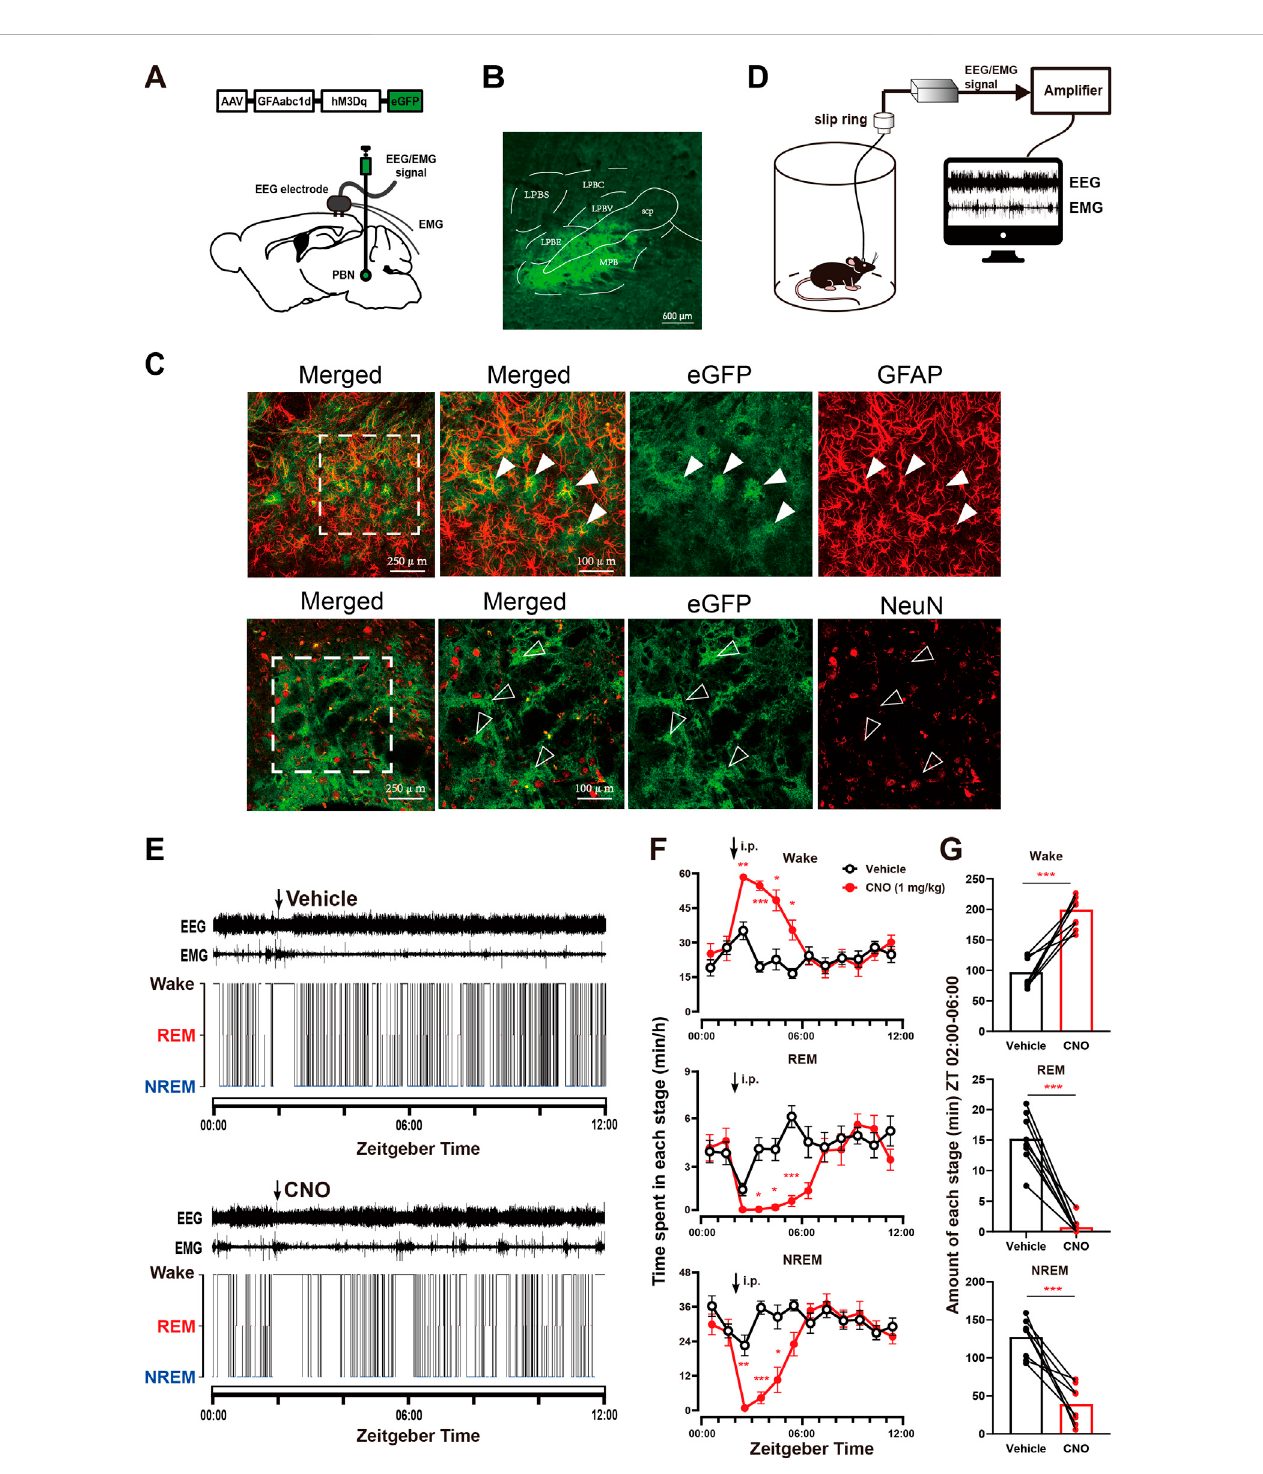
FIGURE 1 Chemogenetic activation of PBN astrocytes increases wakefulness (A) Schematic diagram showing the bilateral injection of AAV-GFAabc1d-hM3Dq- eGFP into the PBN of mice. The electroencephalogram (EEG) electrodes were screwed into the craniotomy hole, and the electromyogram (EMG) electrodes were bilaterallyplaced into the trapezius muscles. (B) Representative fl uorescent image showing the expression of AAV-GFAabc1d-hM3Dq-eGFP in the PBN, scale bar = 600 μ m. LPBC, the central part of the lateral parabrachial nucleus; LPBE, the external part of the lateral parabrachial nucleus; LPBS, the superior part of the lateral parabrachial nucleus; LPBV, the ventral part of the lateral parabrachial nucleus; MPB, medial parabrachial nucleus; scp, superior cerebellar peduncle. (C) Immuno fl uorescenceshowingthecolocalizationofGFAP and eGFP(top),and thecolocalizationofNeuN andeGFP(bottom),closed arrowinshows aGFAP-positive cell.Open arrowshows aNeuN-negative astrocyte.Scale bar= 250 μ mor 100 μ m.GFAP, glial fi brillaryacidic protein; NeuN, neuronal nuclei. (D) Schematic of the con fi guration of the electroencephalographic (EEG)/electromyographic (EMG) with EEG/EMG recording system. (E) TypicalexamplesofEEG/EMGtracesandcorrespondinghypnogramsfromonehM3Dqmousewhichwasintraperitoneallyinjectedwithvehicle(top)orCNO (1 mg/kg, bottom) successively at ZT 02:00. CNO injection was performed 24 h after vehicle injection. (F) Time course of wakefulness, REM sleep, and NREM sleep after intraperitoneal injection of vehicle or 1 mg/kg CNO in hM3Dq mice. Two-way repeated-measures ANOVA ( n = 8). (G) Total time spent in